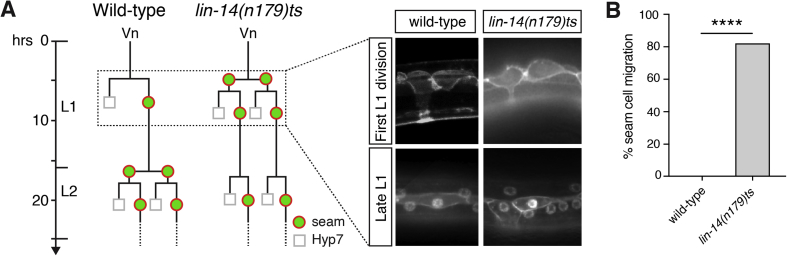
hyp7 fate is not required for seam daughter cell ventral migration.A. Seam V cell lineages of a wild-type and lin-14(n179)ts animal during L1 and L2. Seam cells in lin-14(n179)ts animals grown at the restrictive temperature divide symmetrically to the seam cell fate at the start of L1, precociously undergoing the wild-type L2 pattern of cell divisions during L1. Dotted lines indicate an unrepresented lineage. As in wild-type, the anterior daughter of the first L1 division in lin-14 animals extends a process to the ventral midline, despite being of seam cell fate rather than hyp7 fate. By late L1, this lin-14 anterior seam daughter has moved ventrally and forms a branched seam cell morphology. B. Inappropriate seam cell migration to the ventral midline at the end of L1 in wild-type and lin-14 animals grown at the restrictive temperature [n ​> ​61 per strain; ****P ​< ​0.0001, two-tailed Student’s t-test].